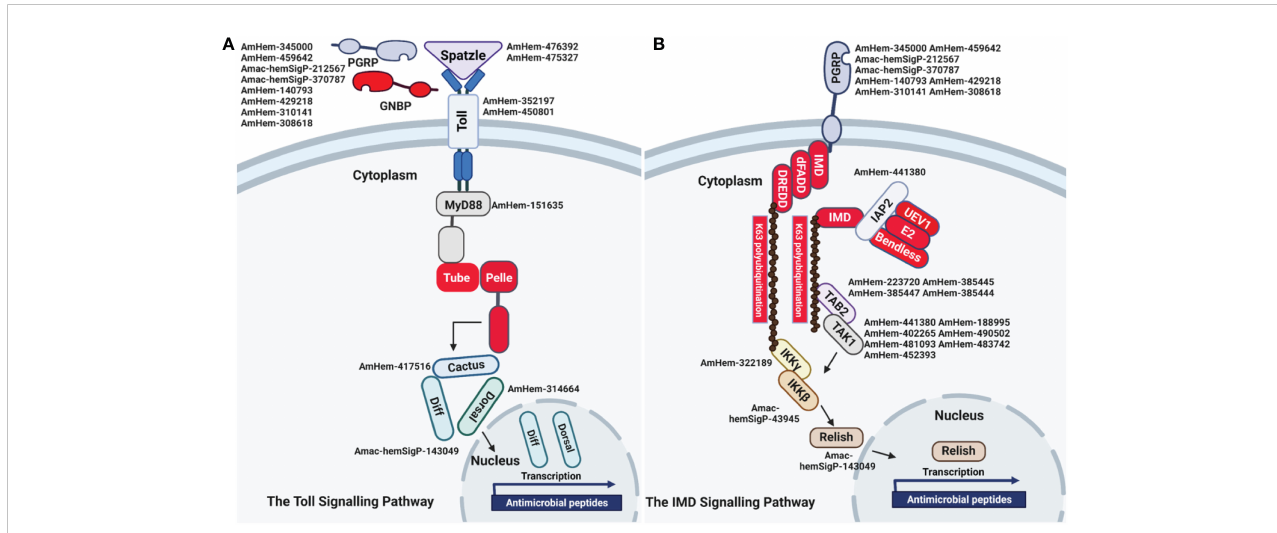
FIGURE 6 Representative signaling pathways and immune-related genes. Reconstruction of the immune-signaling genes derived from R. parkeri- infected and uninfected hemocytes showing the components of the (A) Toll and (B) IMD signaling pathways. The Toll and IMD signaling pathways are highly conserved in ticks. Transcripts highlighted in red were not identi fi ed in this